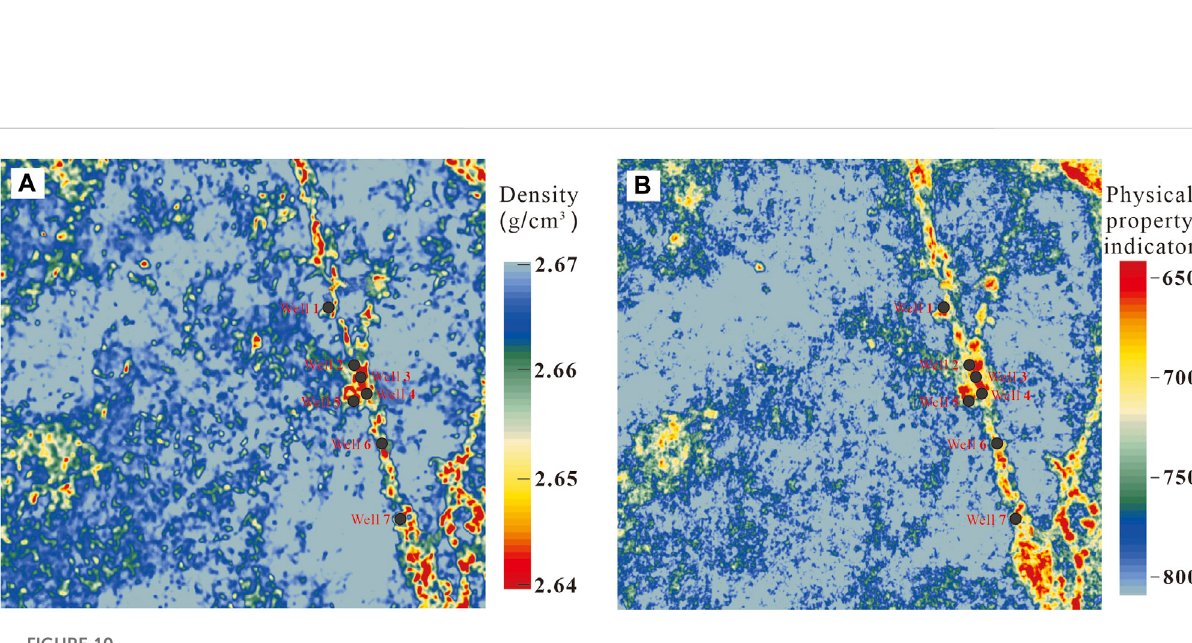
Pro fi le of the average parameter values for the T 7 4 – T 7 6 formation, including the (A) inversion-derived density and (B) the physical property